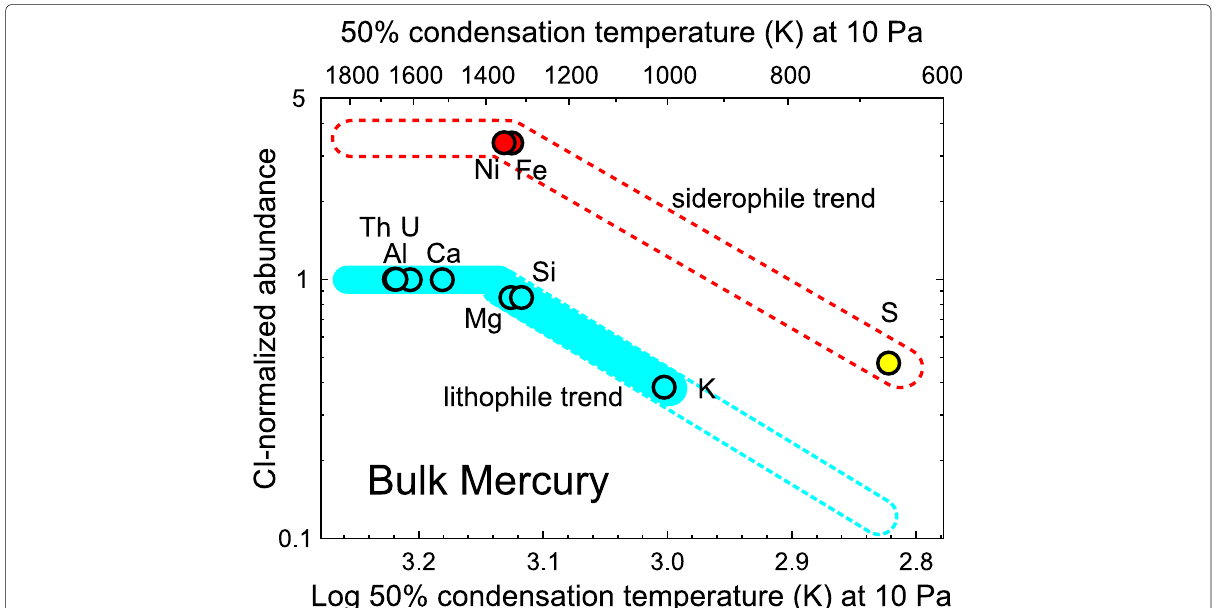
Fig. 3 Normalized abundances of the lithophile (blue) and siderophile (red) elements in the bulk Mercury. Abundances are normalized to Al and CI chondrites and plotted against log of their 50% condensation temperatures (K) at 10 Pa (see Yoshizaki and McDonough (2020)). Volatility trend for Mercury constrains its S content in the core. The predicted S content is consistent with either an extension of the volatile trend for the siderophile and/or and addition of CI chondritic volatiles with 50% condensation temperatures < 1000 K. See text for details